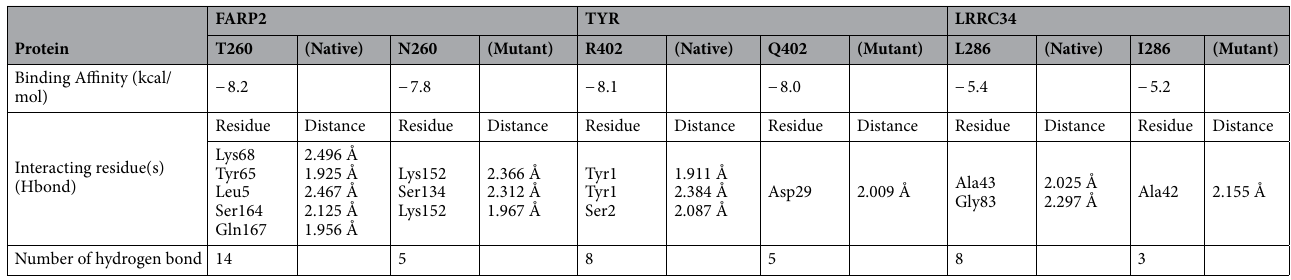
Table 8. Docking results of SRC, DCT and MYNN with native and mutant FARP2, TYR and LRRC34 proteins